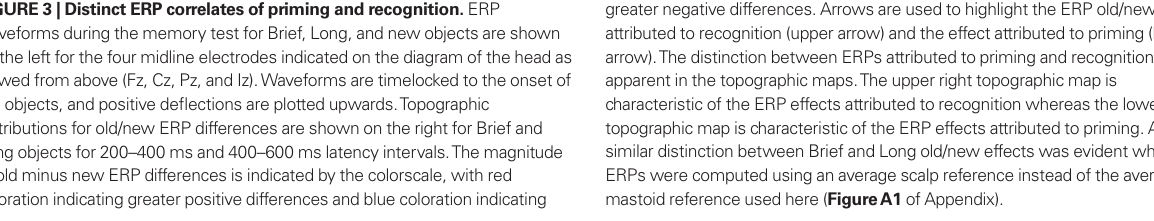
Figure 3 | Distinct erP correlates of priming and recognition. ERP waveforms during the memory test for Brief, Long, and new objects are shown on the left for the four midline electrodes indicated on the diagram of the head as viewed from above (Fz, Cz, Pz, and Iz). Waveforms are timelocked to the onset of the objects, and positive deflections are plotted upwards. Topographic distributions for old/new ERP differences are shown on the right for Brief and Long objects for 200–400 ms and 400–600 ms latency intervals. The magnitude of old minus new ERP differences is indicated by the colorscale, with red coloration indicating greater positive differences and blue coloration indicating